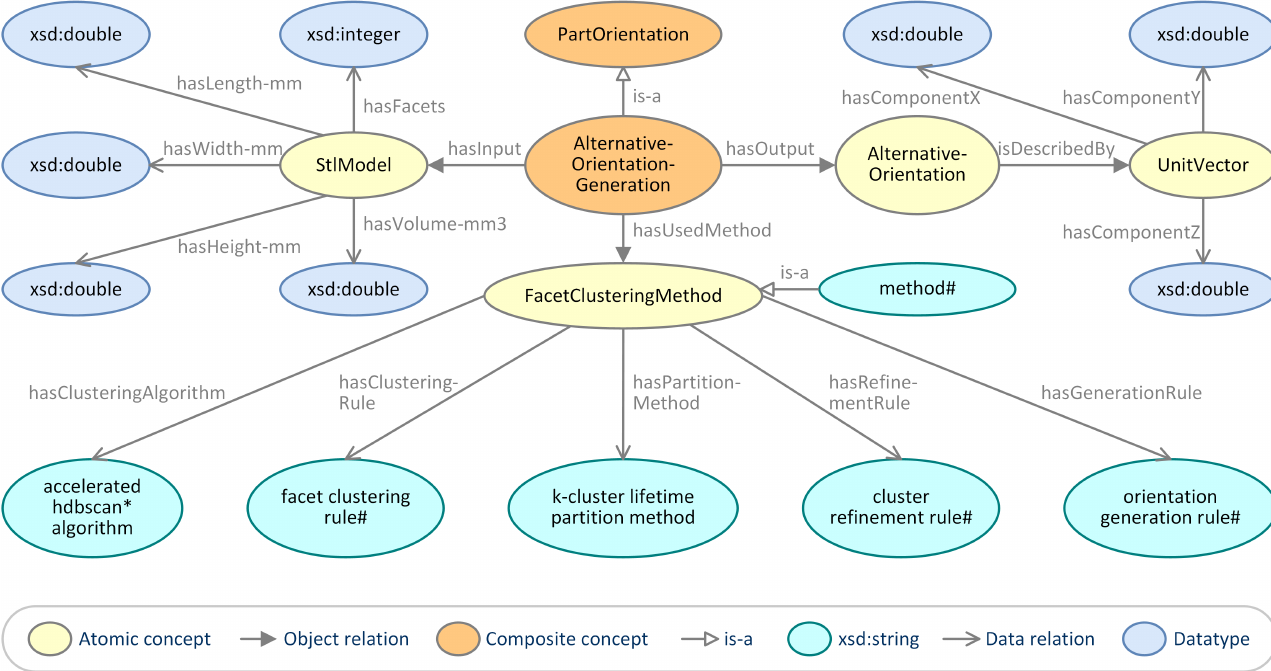
Figure 4. Ontological view of alternative orientation generation. # stands for in